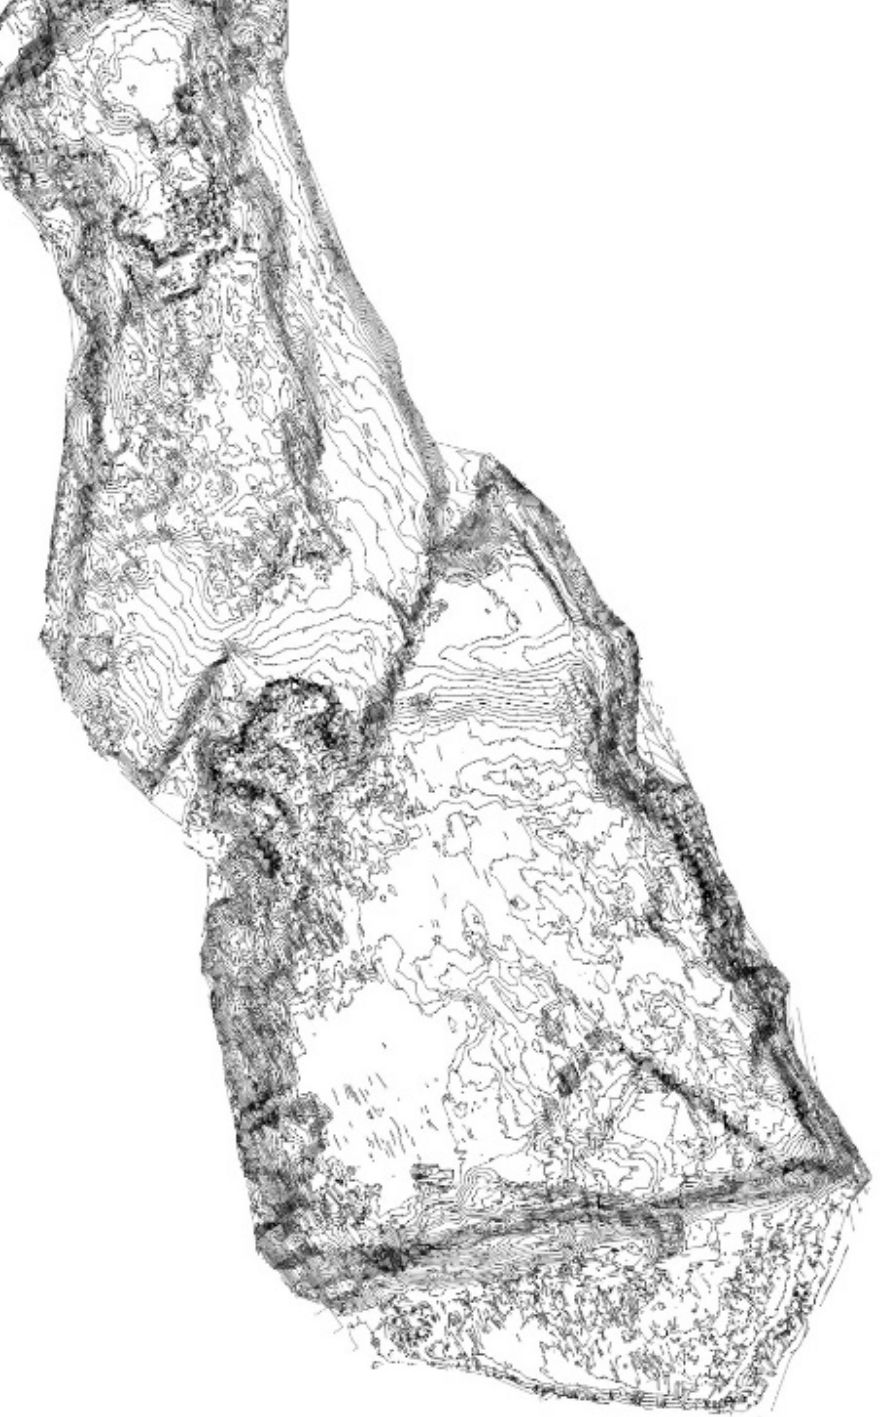
Figure 3. Isolines of the bottom and slopes of Lubstów reservoir obtained from the bathymetric measurements [10].